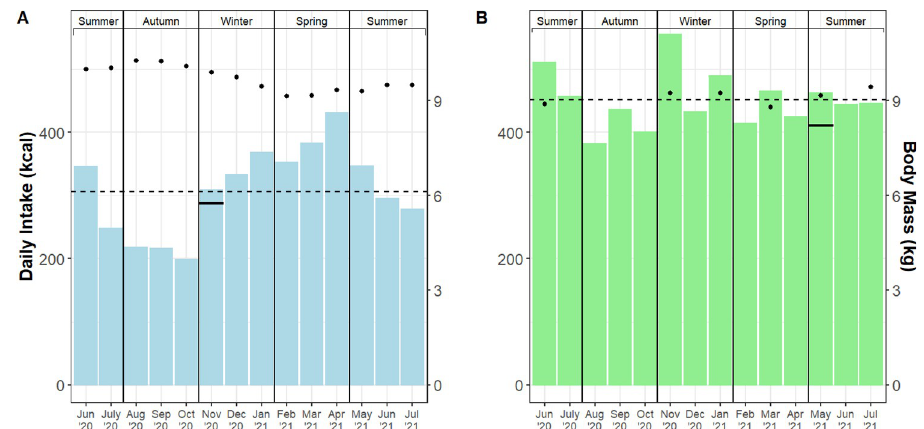
Fig 3. Daily ME intake (kcal day -1 ) and body mass (kg; secondary y-axis) by month for the female (A) and male (B) Matschie’s tree kangaroo ( Dendrolagus matschiei ). Solid horizontal line indicates TEE (kcal day -1 ) in the month it was quantified. Dotted horizontal line represents the mean ME intake over the course of the 14-month study. Black dots represent mean body mass value per month. https://doi.org/10.1371/journal.pone.0270570.g003 ME intake Over the fourteen-month study period, the mean calculated ME intakes for the female and male Matschie’s tree kangaroos averaged 307 ± 154 kcal day -1 and 454 ± 143 kcal day -1 , respec- tively (Fig 3; S2 Table). These ME intake values were similar to the TEE values (female: 288 kcal day -1 ; male: 411 kcal day -1 ) reported above. There were significant seasonal differences in ME intake for the female (F = 15.7; p < 0.001) and male (F = 4.0; p = 0.008). (3, 269) (3, 255) These seasonal changes were largely driven by significantly reduced ME intake in the autumn season for both individuals (Table 3). Table 3 also lists ME intake values scaled to body weight Table 3. Pairwise comparisons of mean seasonal ME intake in zoo housed Matschie’s tree kangaroos ( Dendrolagus matschiei ). Summer Autumn Winter Spring Female N days ME quantified 97 61 58 54